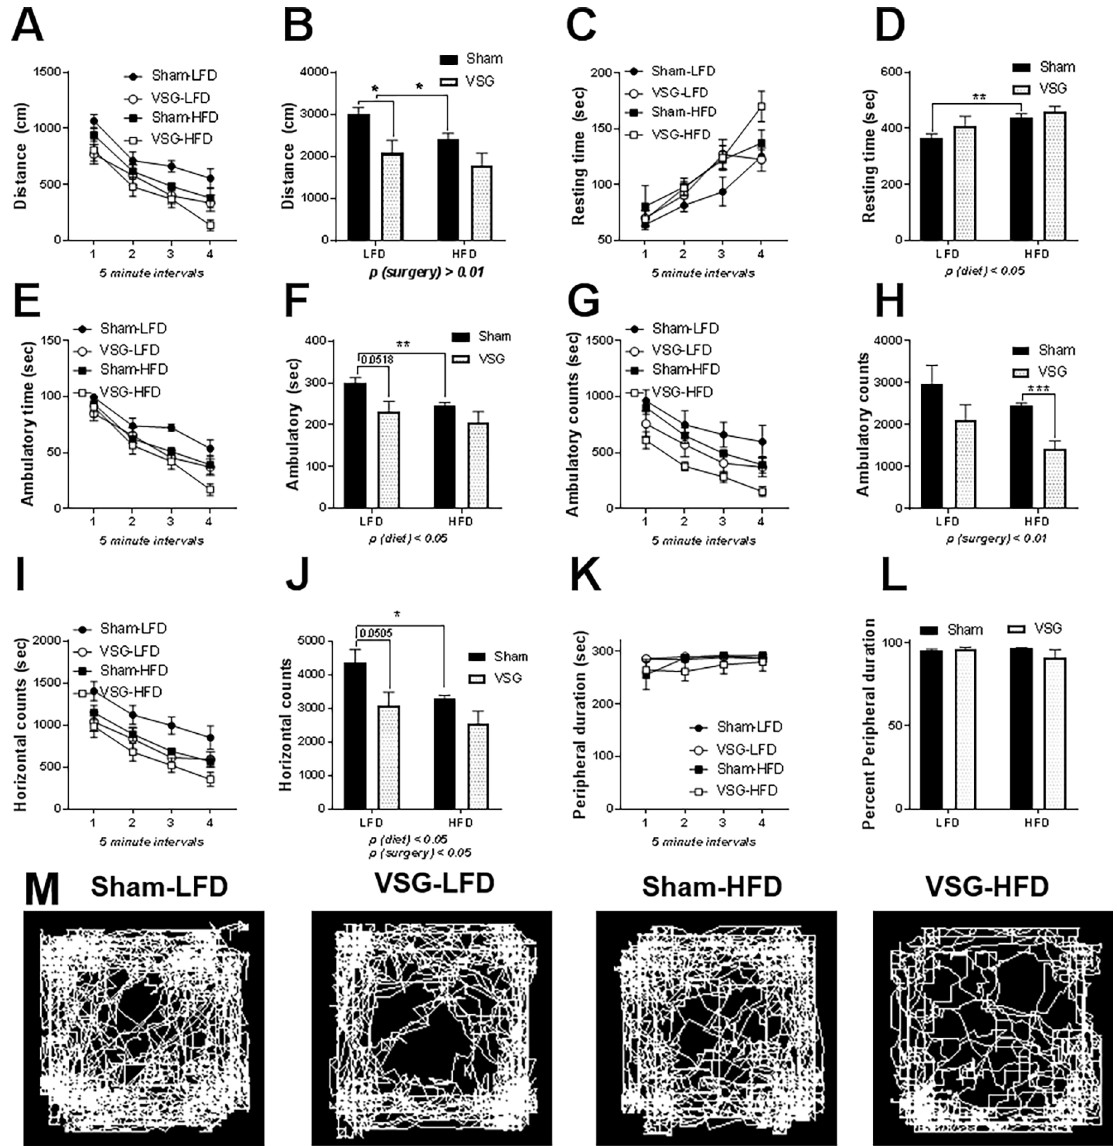
Fig 2. Behavioral analysis of female rats in open field test (OFT). (A) Distance travelled during each of the four 5 minute intervals (B) Cumulative distance travelled during the OFD (cm) during 20 min (C) Distance travelled during each of the four 5 minute intervals (D) Cumulative time spent resting in seconds over the 20 min testing period (E) Time spent ambulating during each of the 5 min intervals (F) Cumulative time ambulating in seconds over the 20 min test (G) Ambulatory counts reported for the 5 min intervals (H) Cumulative ambulatory counts for the 20 min test (I) Horizontal counts reported in 5 minute intervals (J) Cumulative horizontal counts for the 20 min test (K) Duration in sec spent in the periphery reported in 5 min intervals (G) Cumulative duration spent in the periphery (s) for the 20 min test. (M) Representative images of the activity of the animals during the 20 min interval. Cumulative data reported as 2ANOVA by surgery and diet. Data are presented as mean ±SEM. N = 5-7/group. (cid:3) p < 0.05, (cid:3)(cid:3) p < 0.01. (cid:3)(cid:3)(cid:3) p < 0.001.